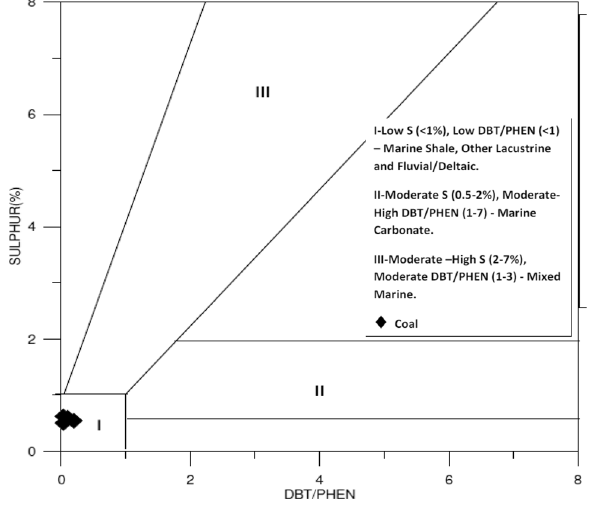
Fig. 19 Cross plot of total sulphur versus dibenzothiophene/phenan- threne (DBT/PHEN) for Maiganga coal (after Hughes et al. 1995). The coal samples are characterized by low sulphur, and low DBT/ PHEN (< 1) indicates fluvio-deltaic